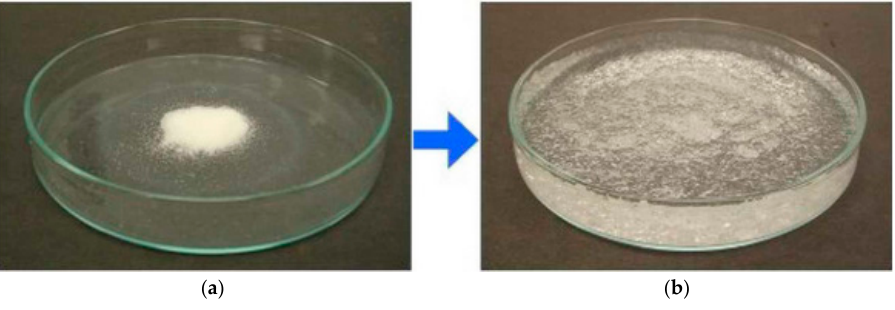
Figure 1. ( a ) Dry SAP powder and ( b ) swollen SAP.